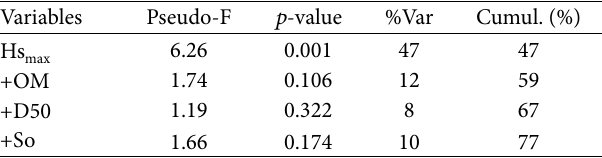
Table 5: Results of distance-based linear model (DISTLM) to assess the effect of environmental parameters on benthic community struc- ture, considering forward selection of variables. %Var: percentage of variance in species data explained by that variable; Cumul. (%): cumulative percentage of variance